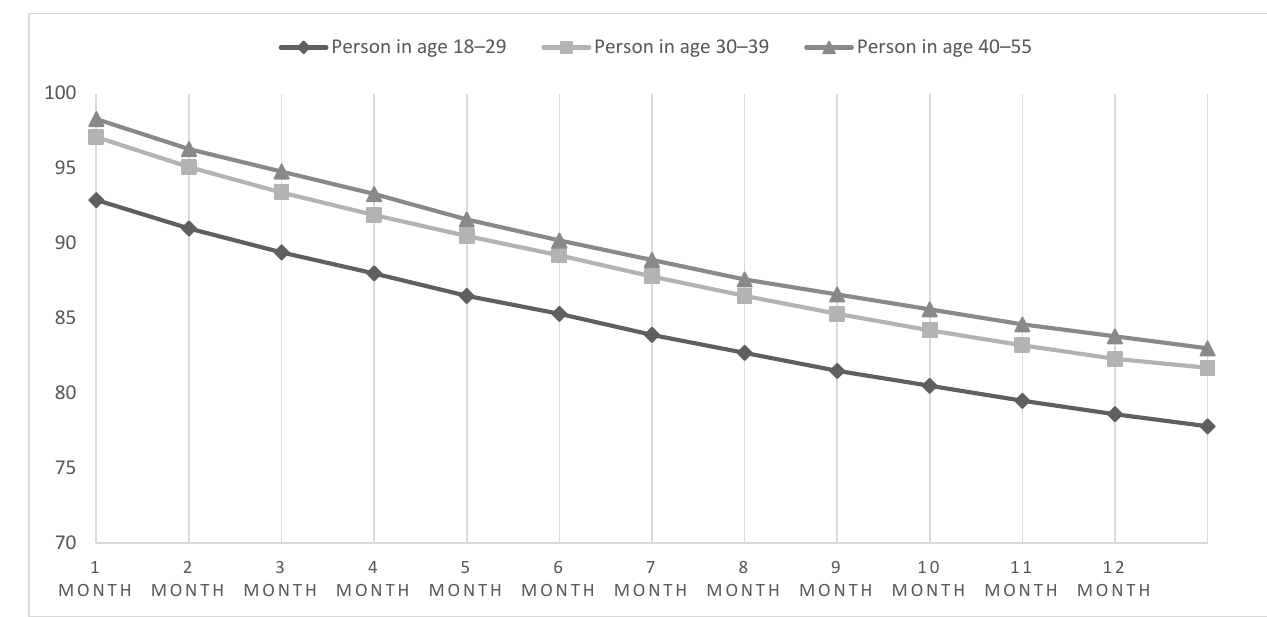
Figure 2. Mean rate of decline in body mass in the 3 age groups over 12 months [kg].